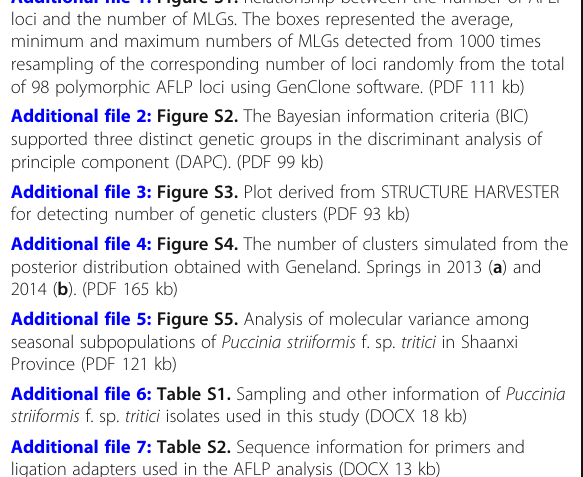
Additional file 1: Figure S1. Relationship between the number of AFLP loci and the number of MLGs. The boxes represented the average, minimum and maximum numbers of MLGs detected from 1000 times resampling of the corresponding number of loci randomly from the total of 98 polymorphic AFLP loci using GenClone software. (PDF 111 kb) Additional file 2: Figure S2. The Bayesian information criteria (BIC) supported three distinct genetic groups in the discriminant analysis of principle component (DAPC). (PDF 99 kb) Additional file 3: Figure S3. Plot derived from STRUCTURE HARVESTER for detecting number of genetic clusters (PDF 93 kb) Additional file 4: Figure S4. The number of clusters simulated from the posterior distribution obtained with Geneland. Springs in 2013 ( a ) and 2014 ( b ). (PDF 165 kb) Additional file 5: Figure S5. Analysis of molecular variance among seasonal subpopulations of Puccinia striiformis f. sp. tritici in Shaanxi Additional file 6: Table S1. Sampling and other information of Puccinia striiformis f. sp. tritici isolates used in this study (DOCX 18 kb) Additional file 7: Table S2. Sequence information for primers and ligation adapters used in the AFLP analysis (DOCX 13